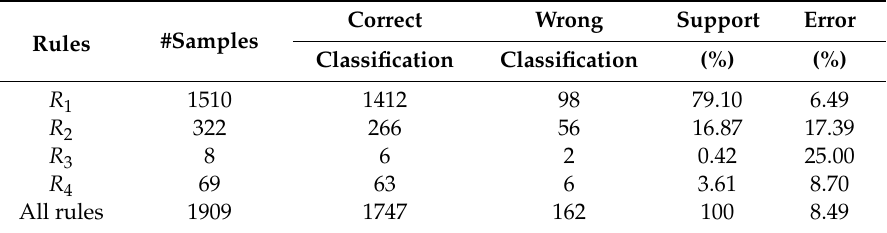
Table 3. Support level and error rate of the rules generated using CART with only discrete attributes.